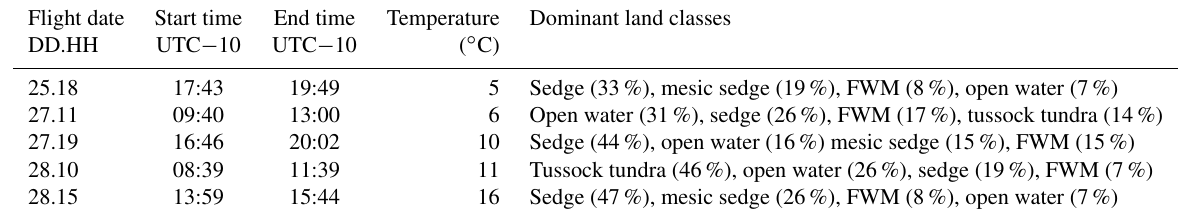
Table 1. Description of the August 2013 flights. Flight date is the day of the flight in August (DD) and the “middle time” of flight to the nearest hour (HH). Temperature is the air temperature measured during the flight, averaged over all measurements made below 100m. The dominant land classes are listed in order of decreasing relative contribution to the observed fluxes, determined by footprint analysis coupled with a land cover map. (FWM refers to fresh water marsh).